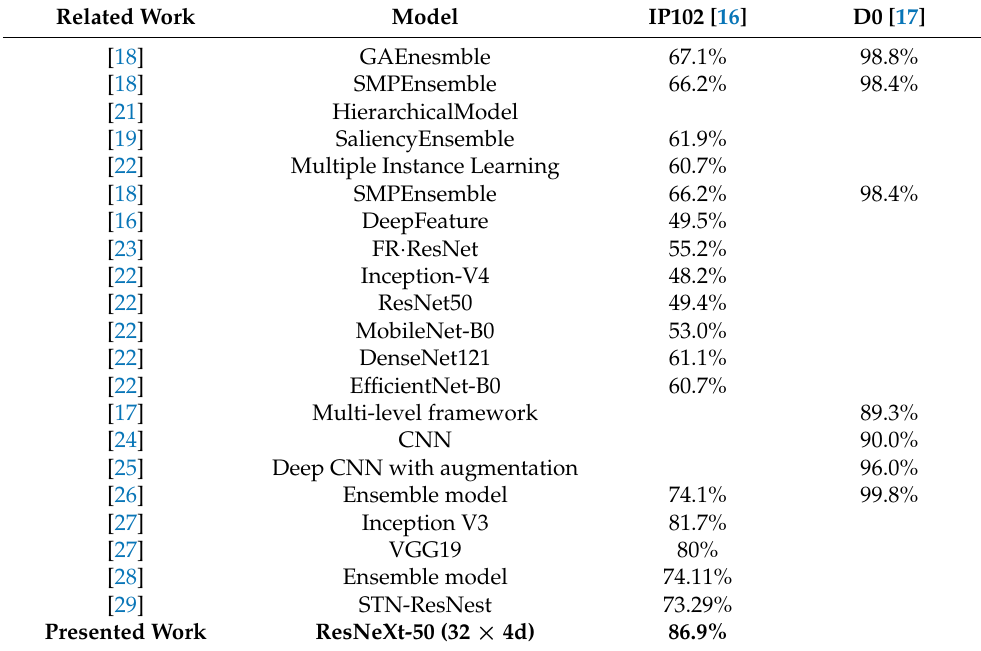
Table 1. The comparative result with related